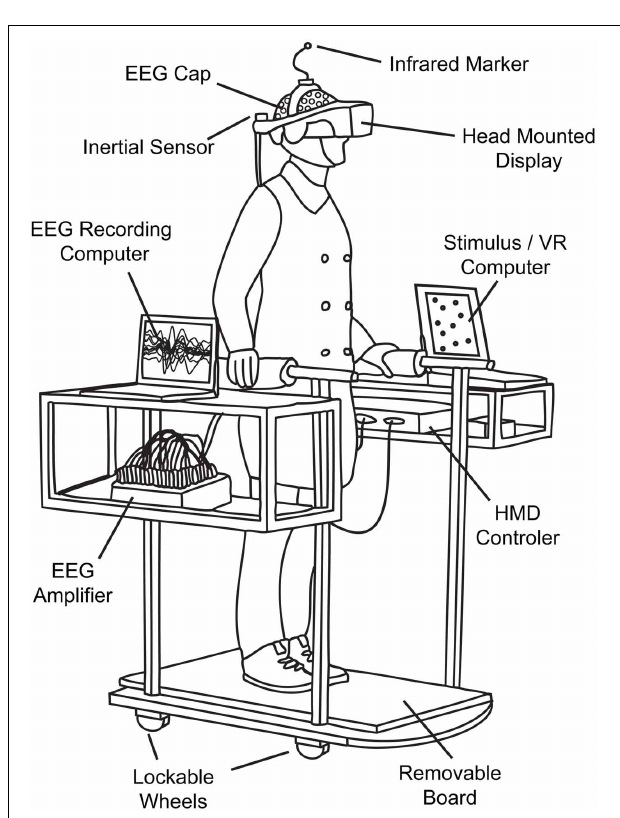
FIGURE 2 | Technical setup. The cart ensured that subjects stayed on track and completed the predefined path as required. It furthermore served as convenient repository for auxiliary mobile VR and EEG equipment like laptops or amplifiers.